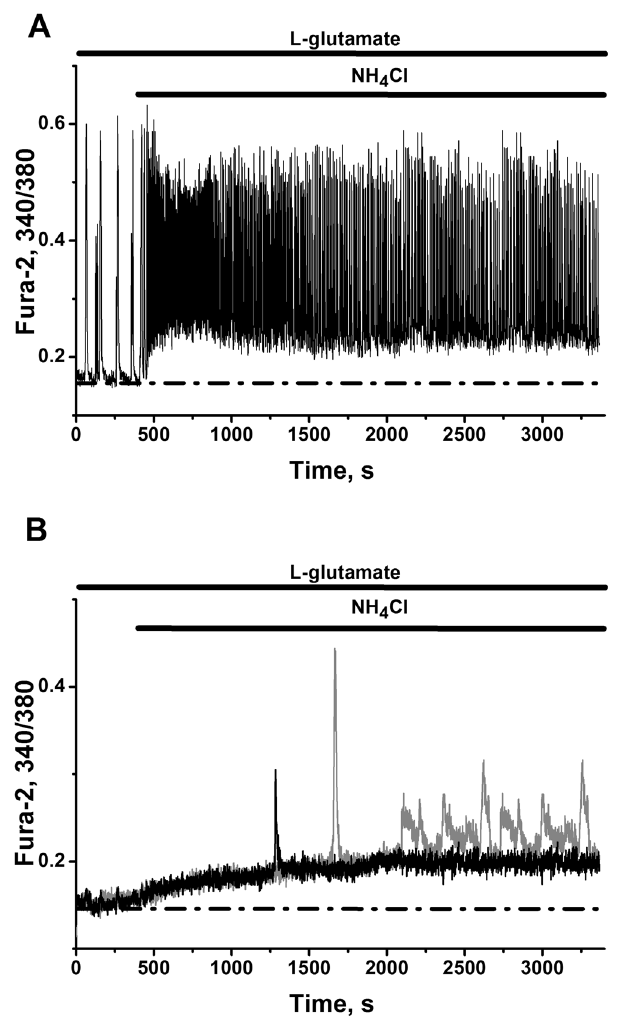
Fig 5. Comparative simultaneous recordings of Ca 2+ -oscillations in representative neuronal cell (A) and calcium signaling in two types of astrocytes (B) in network activated by 6 mM NH 4 Cl. Neuronal culture 14 DIV. Part of the experiment presented on Fig 4. All conditions as at Fig 4. (A) Recording of Ca 2+ oscillations in representative neuronal cell (95% of cells) after application of NH 4 Cl. This is the repeat of the recording presented on Fig 4A. (B) Recordings of two types of responses of representative astrocytes are shown. NH 4 Cl slightly increases astrocyte Ca 2+ i level with generation of solitary Ca 2+ spikes in 44 of 67 cells (black line) and induce chaotic Ca 2+ oscillations in 23 of 67 cells (gray